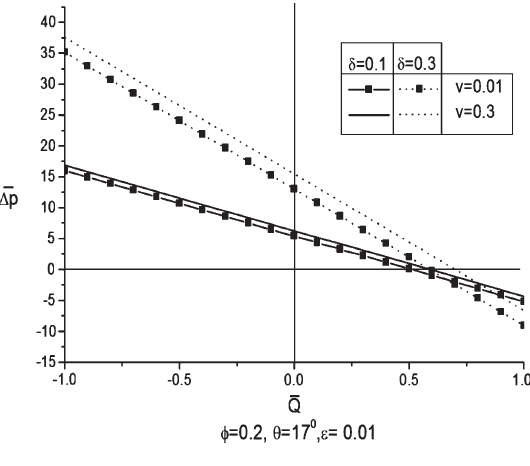
Fig. 5. Variation of pressure rise over the length versus ¯ Q with different values of inner cylinder velocity v with different δ .